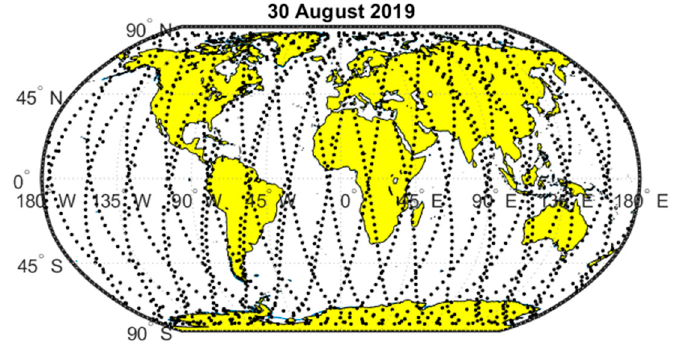
Figure 3. Typical points of radiation measurements.